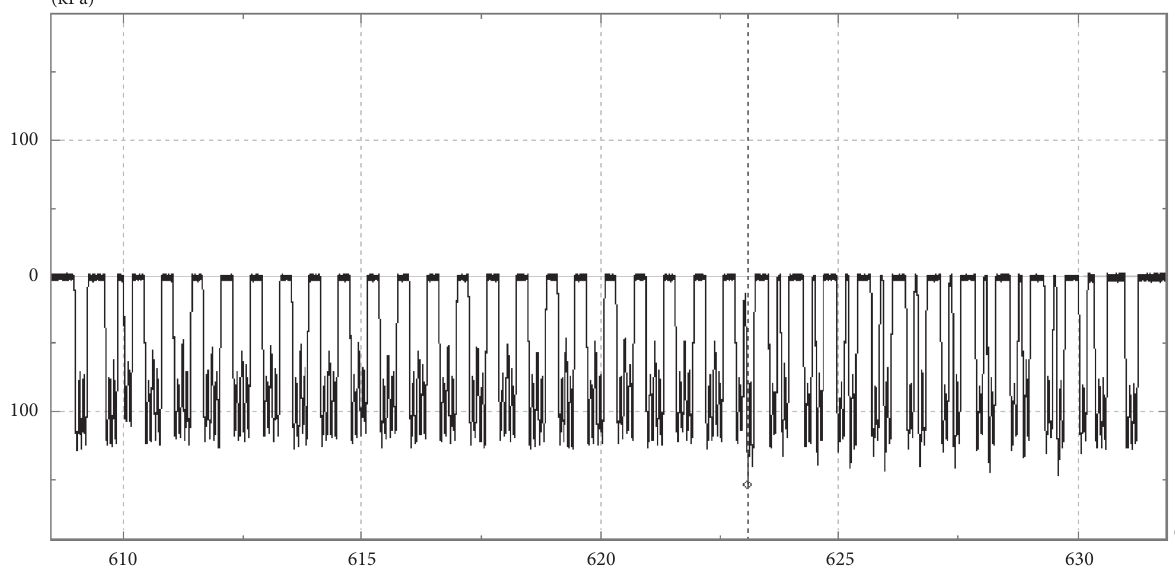
Figure 13: Vertical dynamic stress of the top surface of invert filling layer under the track in the cracked zone.